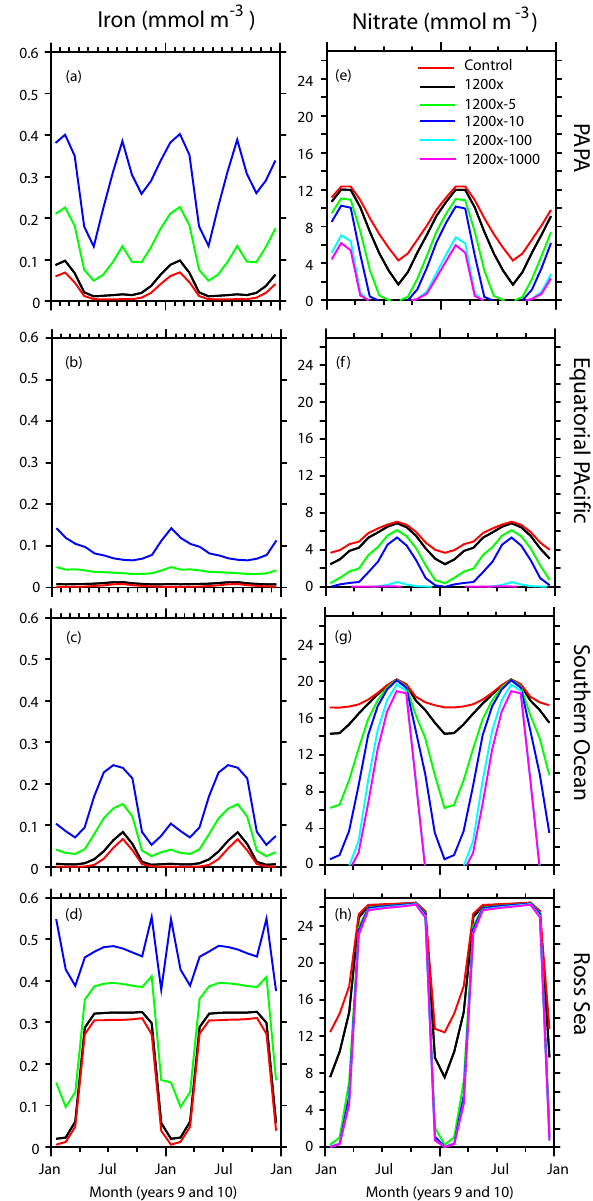
Fig. 13. Mean iron and nitrate in the top 10m of the four fertil- ization sites after 10 years of constant fertilization with increasing additions of iron expressed here as a multiple of the standard 1200x scenario. The 1200x-100 and 1200x-1000 iron concentration pro- files are off-scale. Note that the mean surface nitrate concentration stabilizes after ∼ 4 years of continuous fertilization so the 10 year concentration is pretty much already at steady state for the given fertilization